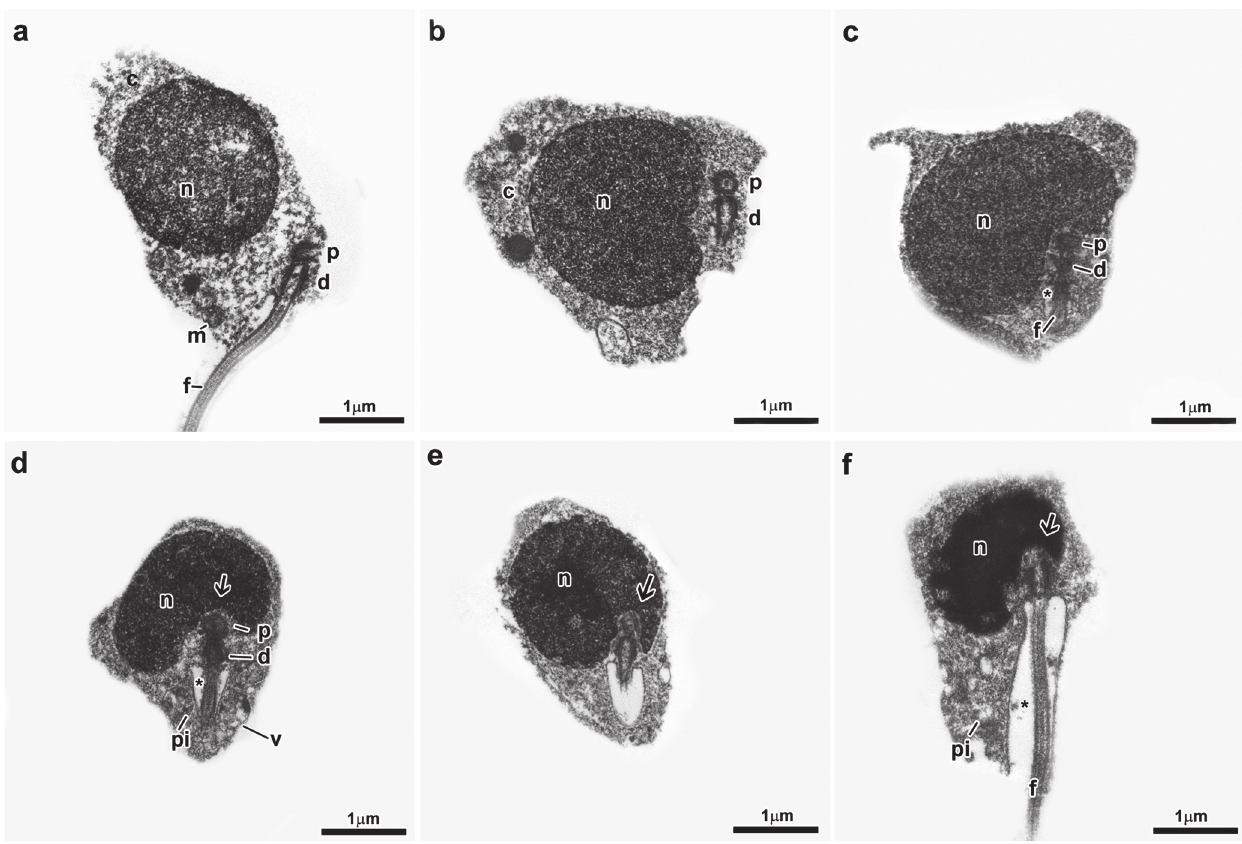
Fig. 1. Spermiogenesis process of the Alestidae. Figure subunits are longitudinal sections of spermatids corresponding to (a, b) Brycinus lateralis , (c) Brycinus imberi , (d) Brachypetersius altus , (e) Alestopetersius compressus , (f) Micralestes acutidens . The flagellum is initially lateral to the nucleus. The nuclear rotation towards the flagellar axis is present. The nuclear rotation can be complete reaching 90 degrees as represented by the late spermatid of Alestopetersius compressus (e), or incomplete reaching about 20 degrees as occurs in the late spermatid of Micralestes acutidens (f). Legends: c: cytoplasm, d: distal centriole, f: flagellum, m: mitochondria, n: nucleus, p: proximal centriole, pi: midpiece, v: vesicle, asterisk: cytoplasmic canal, arrow: nuclear